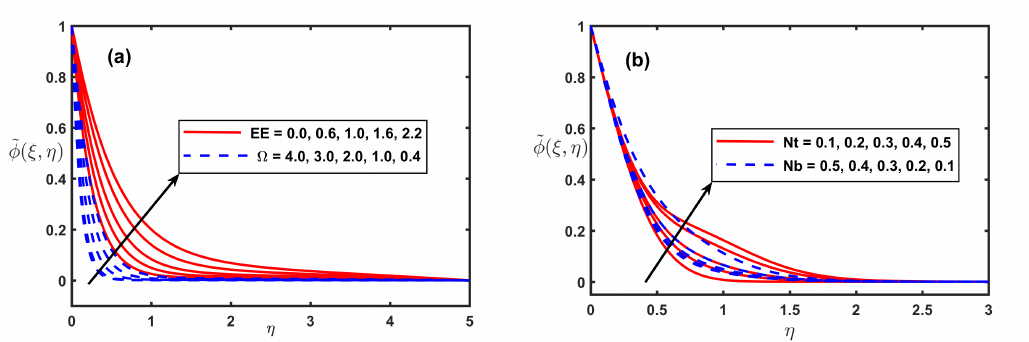
Figure 7. Fluctuation of ˜ θ ( ξ , η ) along with Nb, Nt, γ T , and Q s .